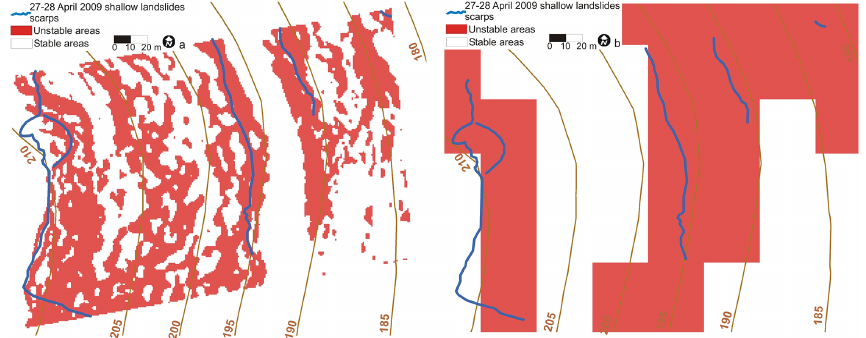
Figure 12. Modelled scenarios for 27–28 April 2009 event for the monitored slope using different DEMs with grid size of 2m × 2m (a) and 10m × 10m (b) .